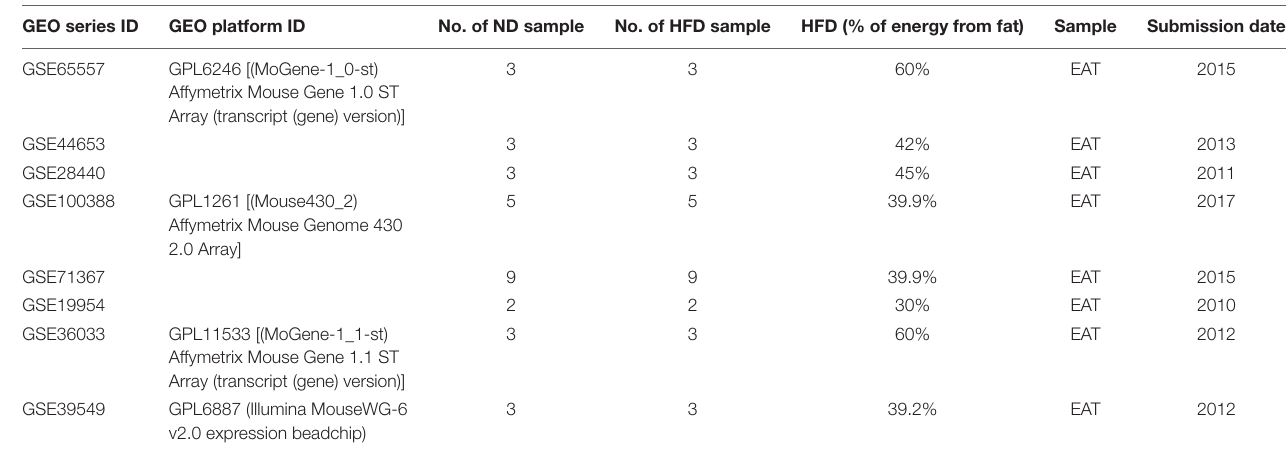
TABLE 1 | List of datasets used in meta-analysis. GEO series